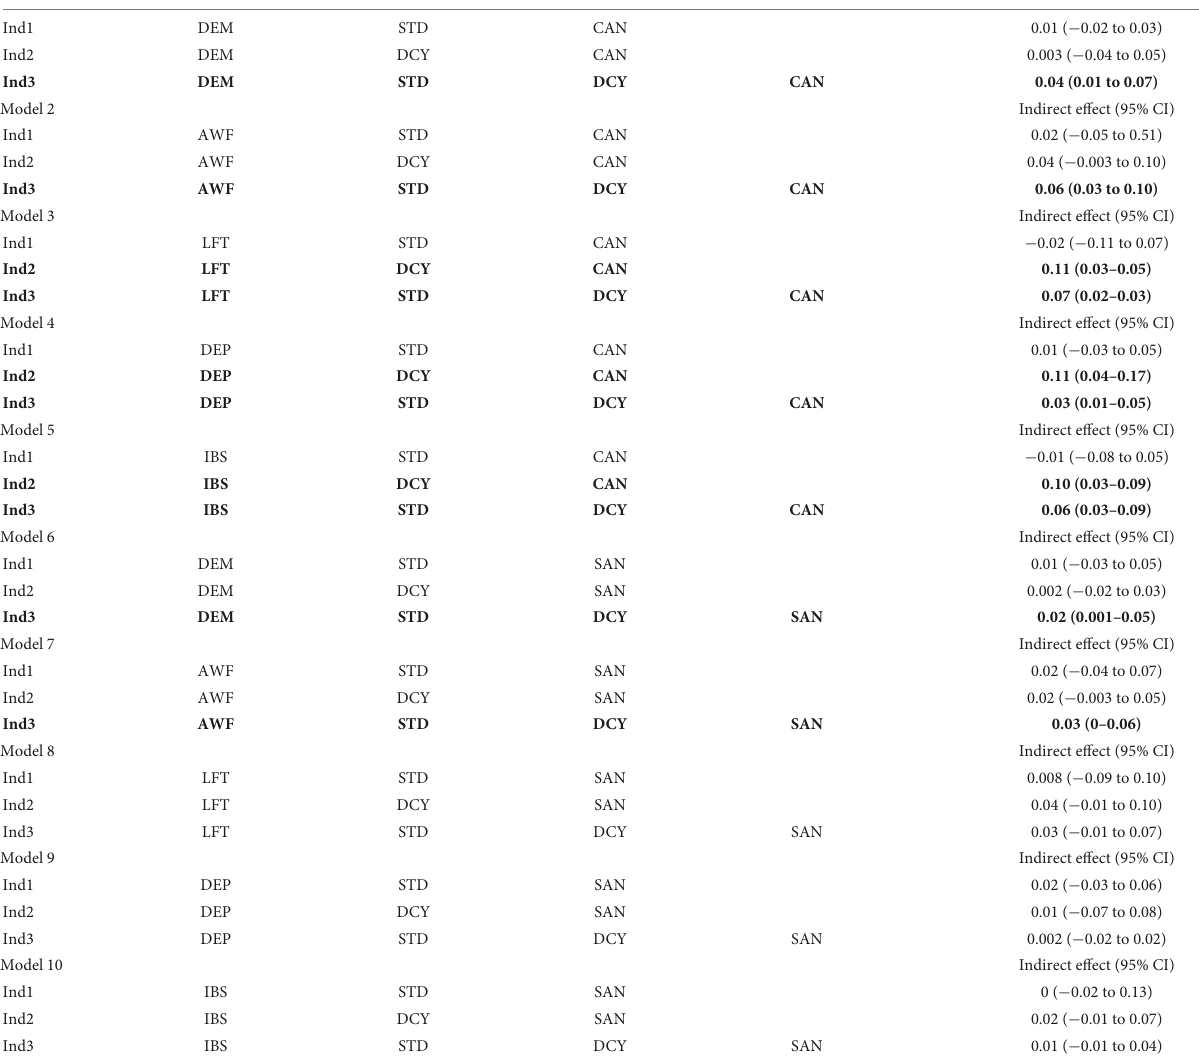
TABLE 3 Indirect effects of serial atemporal multiple mediations (SAMM). Model